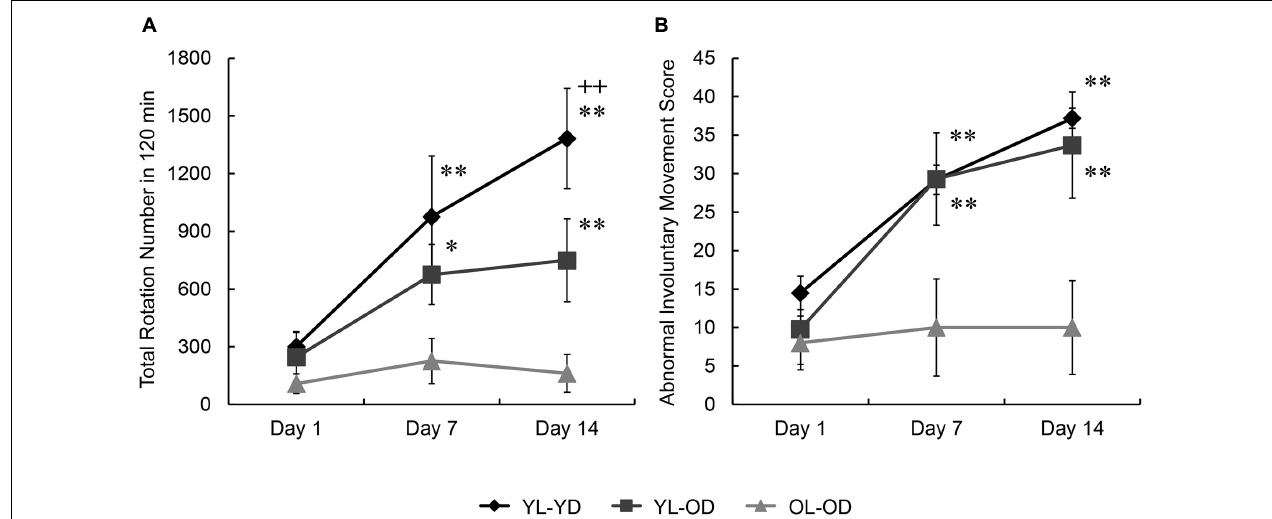
FIGURE 2 | Rotational behavior and abnormal involuntary movement induced by repetitive L -dopa treatment in three groups of Parkinson’s disease rat model. (A) No between-group differences in the total number of rotations on day 1. On days 7 and 14, the YL-YD and YL-OD groups showed a higher number of rotations than the OL-OD group. On day 14, the YL-YD group showed a higher number of rotations than the YL-OD group. (B) No between-group differences in ALO AIM scores on day 1. On days 7 and 14, the YL-YD and YL-OD groups showed higher scores than the OL-OD group. Scores of the YL-YD and YL-OD groups were not different. * p < 0.05; ** p < 0.01 compared with the OL-OD group on the treatment day; ++ p < 0.01 compared with the YL-OD group on the treatment day. Error bars represent the standard error of the mean. ALO AIM score, sum score of axial, forelimb, and orolingual scores; L -dopa, levo-dihydroxyphenylalanine; OL-OD, old-lesioned old- L -dopa group; YL-OD, young-lesioned old- L -dopa group; YL-YD, young-lesioned young- L -dopa